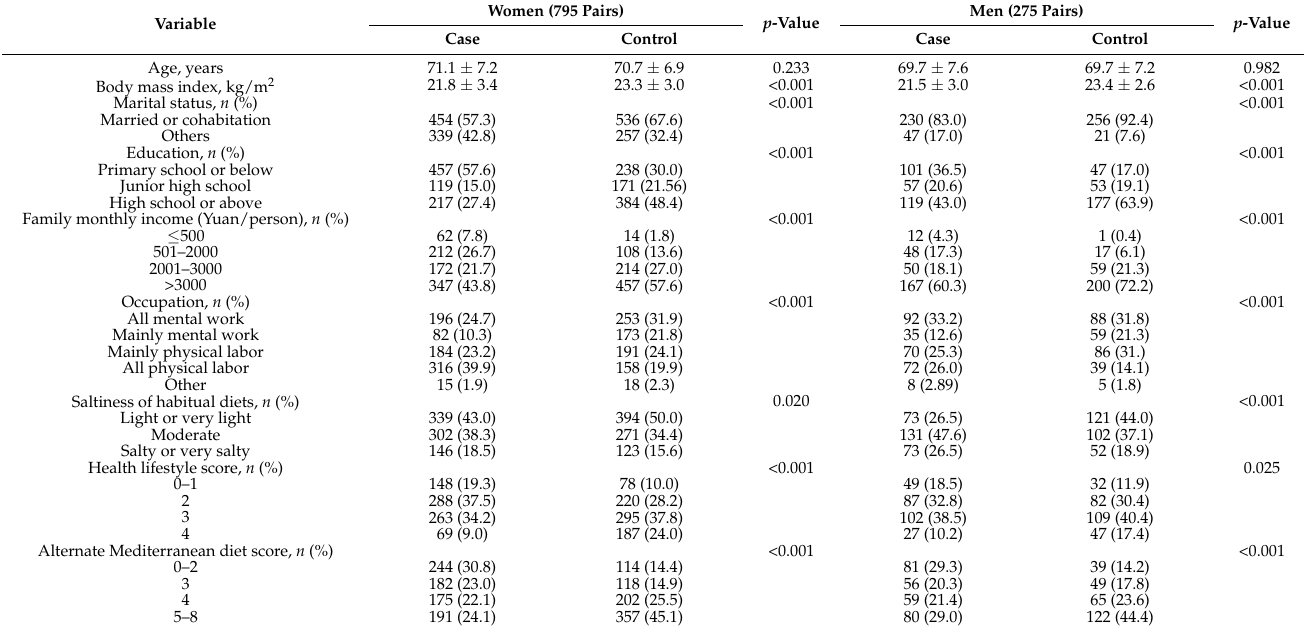
Table 1. Demographic and socio-behavioral characteristics and selected hip fracture risk factors of the study population (1070